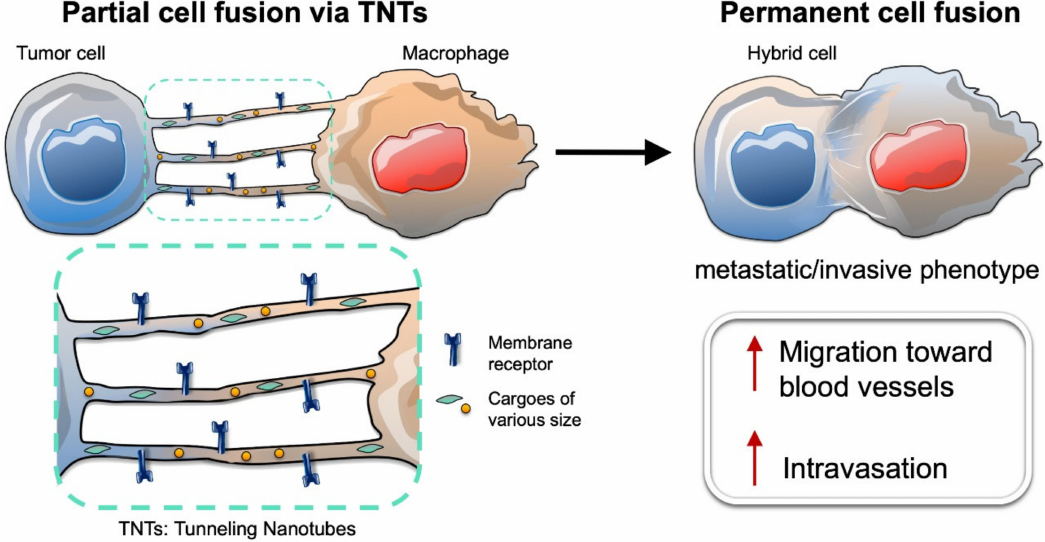
Figure 2. Illustration of partial cell fusion via tunneling nanotubes (TNTs) and permanent cell fusion. (up-arrow: increased